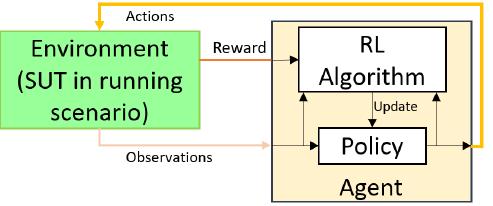
Figure 1. The reinforcement learning algorithm’s block